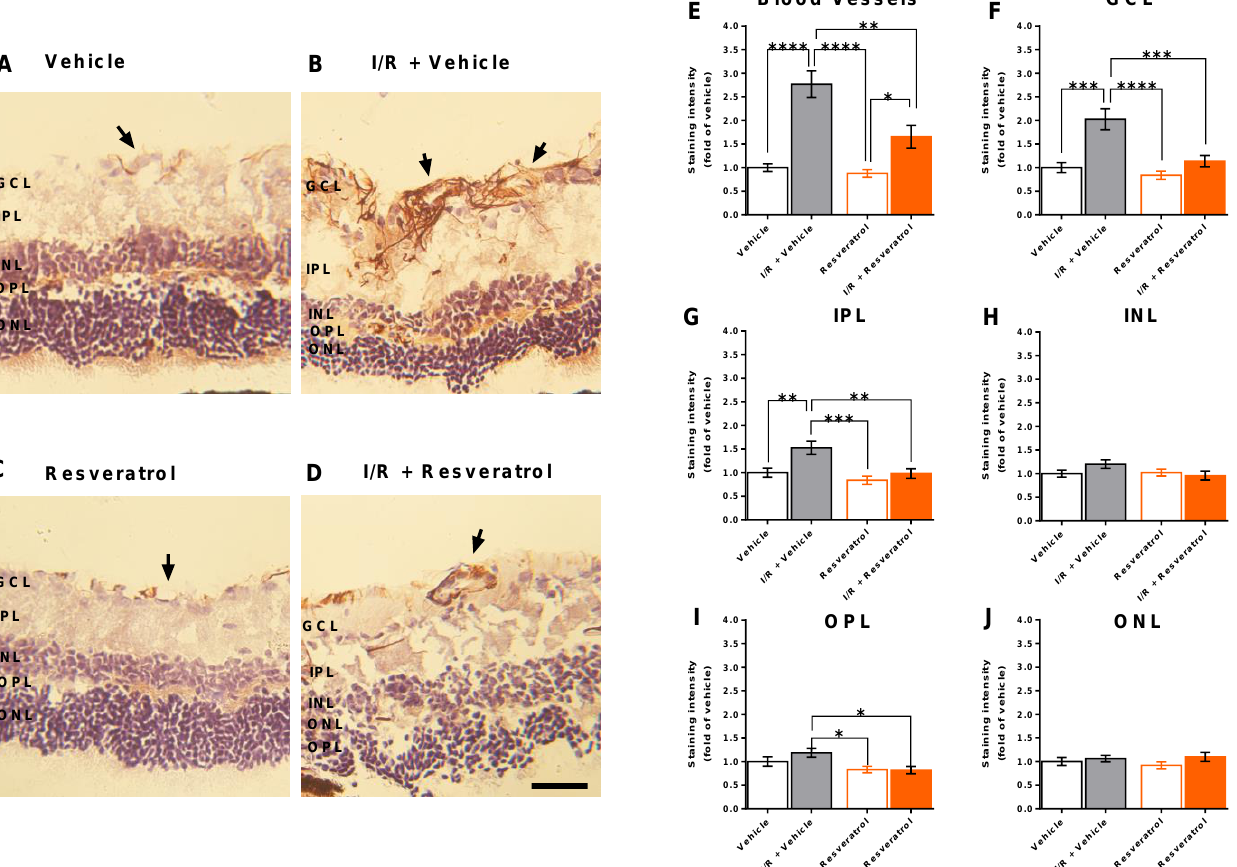
Figure 4. Anti-3-nitrotyrosin staining (brown color) in retinal cross-sections. ( A – D ) Representative pictures of retinal cross-sections from each group. The black arrows point to the blood vessels. Scale bar = 50 µm. ( E – J ) Anti-3-nitrotyrosin staining intensity was markedly increased in retinal blood vessels ( E ), in the GCL ( F ), in the IPL ( G ) and in the OPL ( I ) from I/R- and vehicle-treated eyes. Remarkably, resveratrol-treatment prevented the I/R-induced increase in anti-3-nitrotyrosin reactivity. In the INL ( H ) and in the ONL ( J ) no marked differences in anti-3-nitrotyrosin staining intensity were seen between groups. Values are expressed as the means ± SE (**** p < 0.001; *** p < 0.001; ** p < 0.01; * p < 0.05; n = 8 per group). GCL, ganglion cell layer; IPL, inner plexiform layer; INL, inner nuclear layer; OPL, outer plexiform layer; ONL, outer nuclear